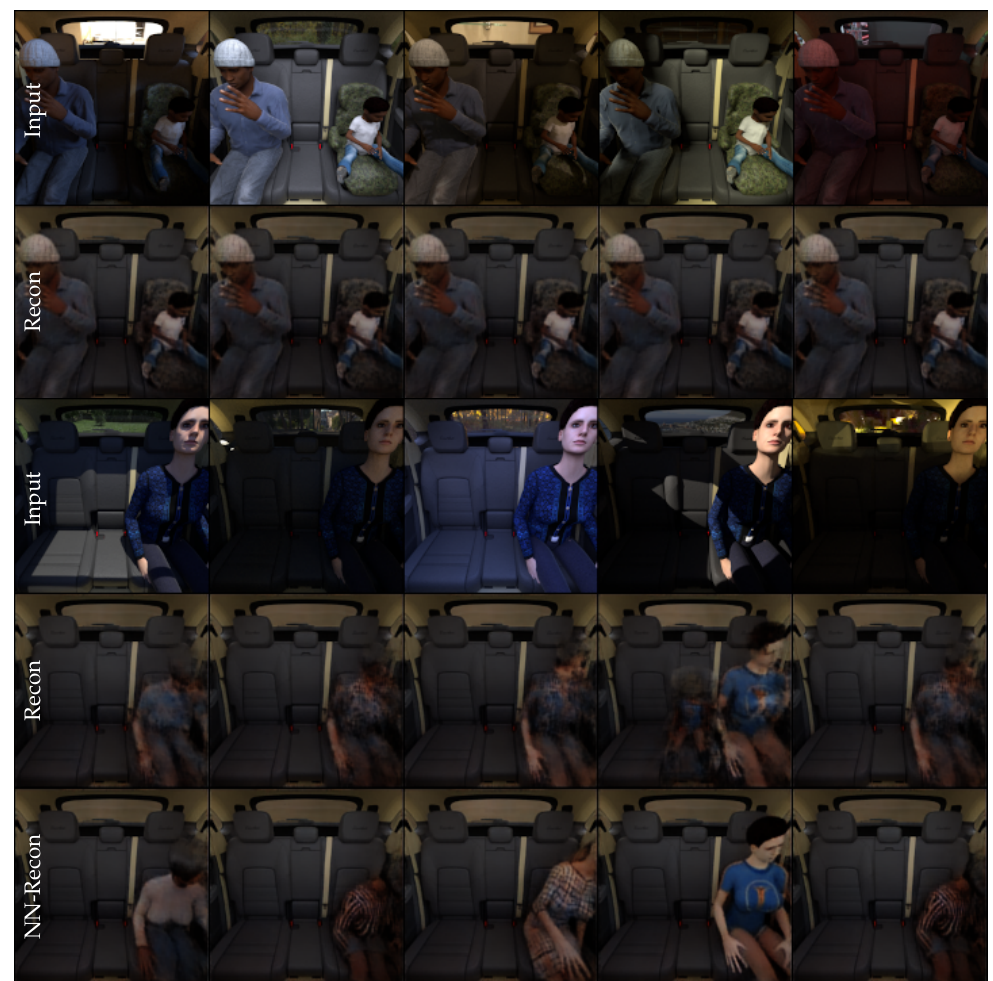
Figure 6. The encoder–decoder model transforms the input images of the same scenery (first row) into a cleaned version (second row) by removing all illumination and environment information (see the background through the window). The test image (third row) cannot be reconstructed perfectly (fourth row). Choosing the nearest neighbour in the latent space and reconstructing the latter leads to a class-preserving reconstruction (fifth